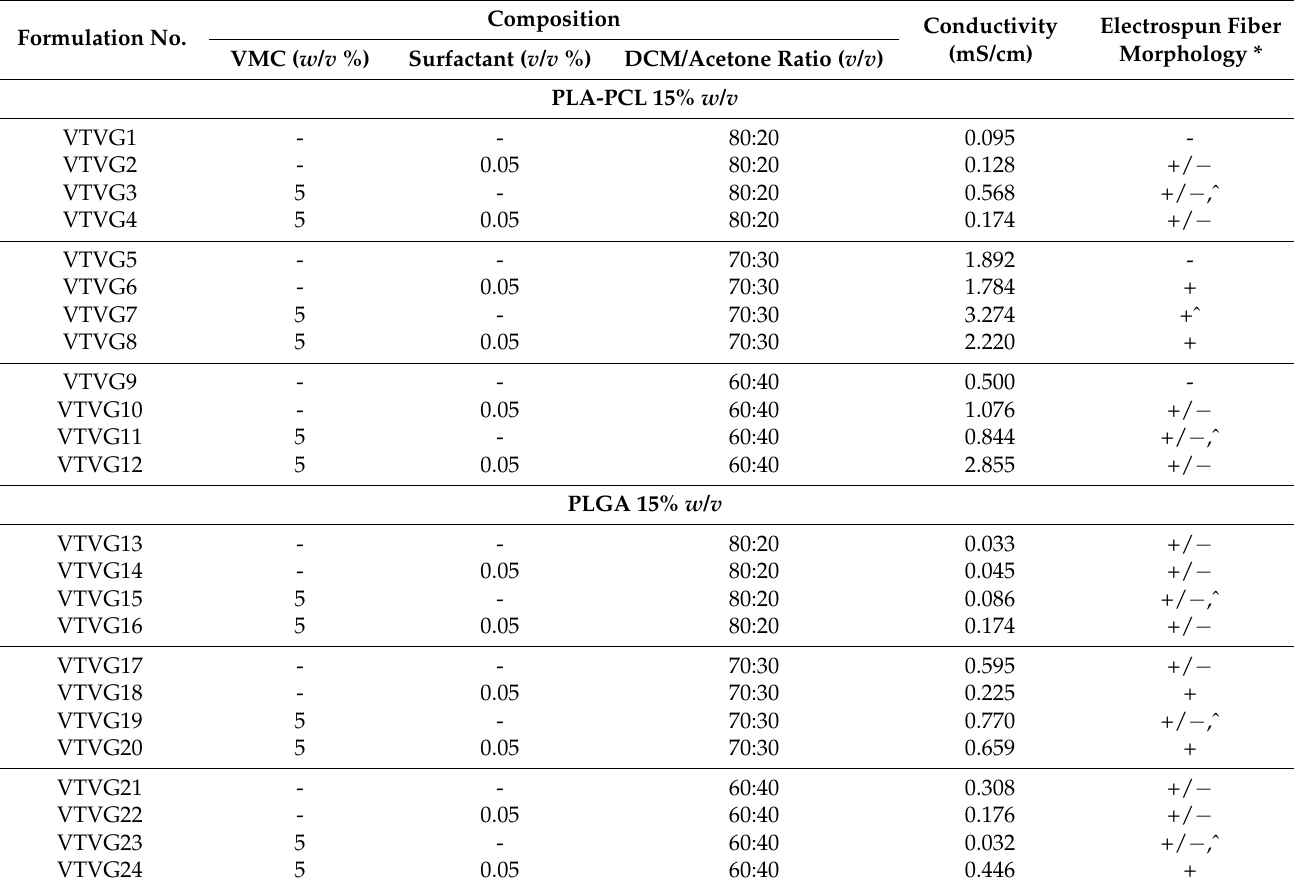
Table 2. Composition of VTVG formulations, conductivity values, and morphology of electrospun fiber. Formulation